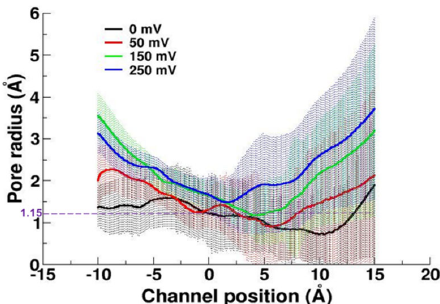
Figure 7. Radii of the channel pore of four simulations.